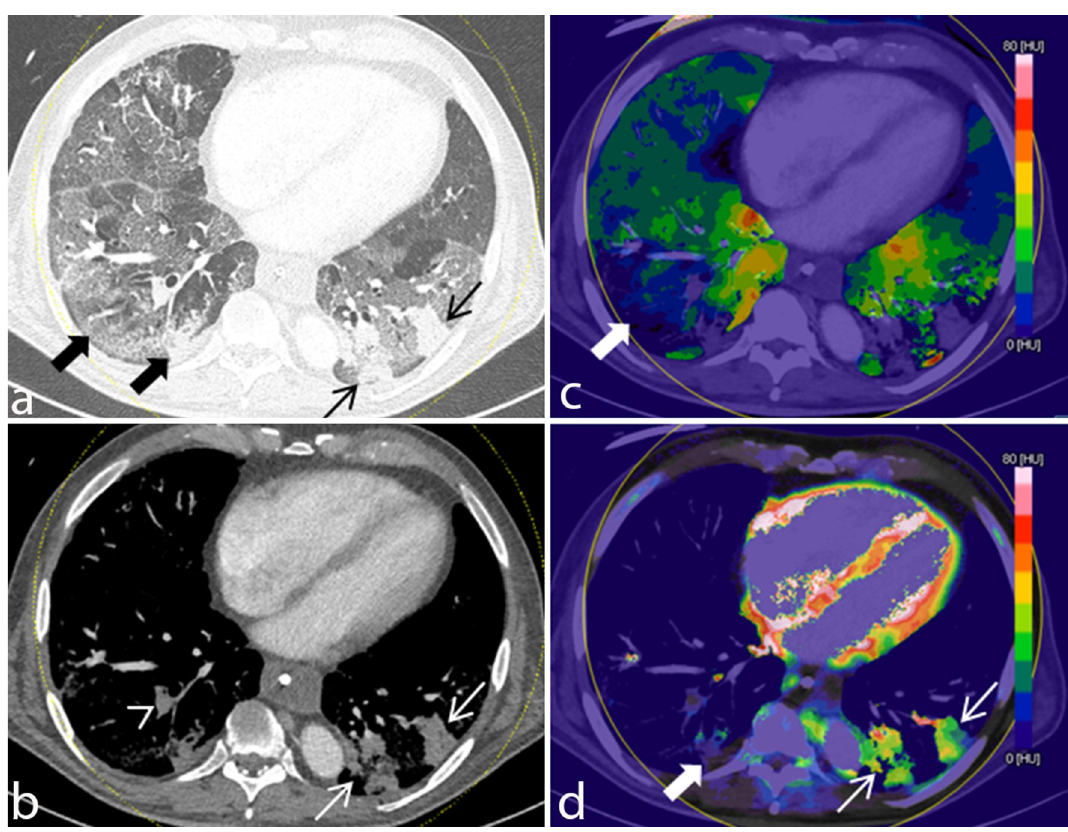
thresholds for tissue recognition set to minimum -960 HU and maximum -400 HU for visualisation of iodine density in normally aerated lung and GGO and d. colour-coded PBV MIP with thresholds for tissue recognition set to minimum -100 HU and maximum +150 HU for visualization of iodine density in consolidation. Parameter settings were separated for this illustration only in order to enable a clear depiction of perfusion differences by optimizing the range of the look-up table to tissue density. Extensive diffuse GGO is present. Several consolidations are seen in the posterior segments of both lower lobes. Subsegmental pulmonary embolism is identified in the right lower lobe (arrowhead). Iodine density of lung tissue downstream of PE (bold arrows) is decreased while iodine uptake in GGO and in particular in consolidations (thin arrows) without upstream PE is increased compared to normally aerated lung (see colour- coding